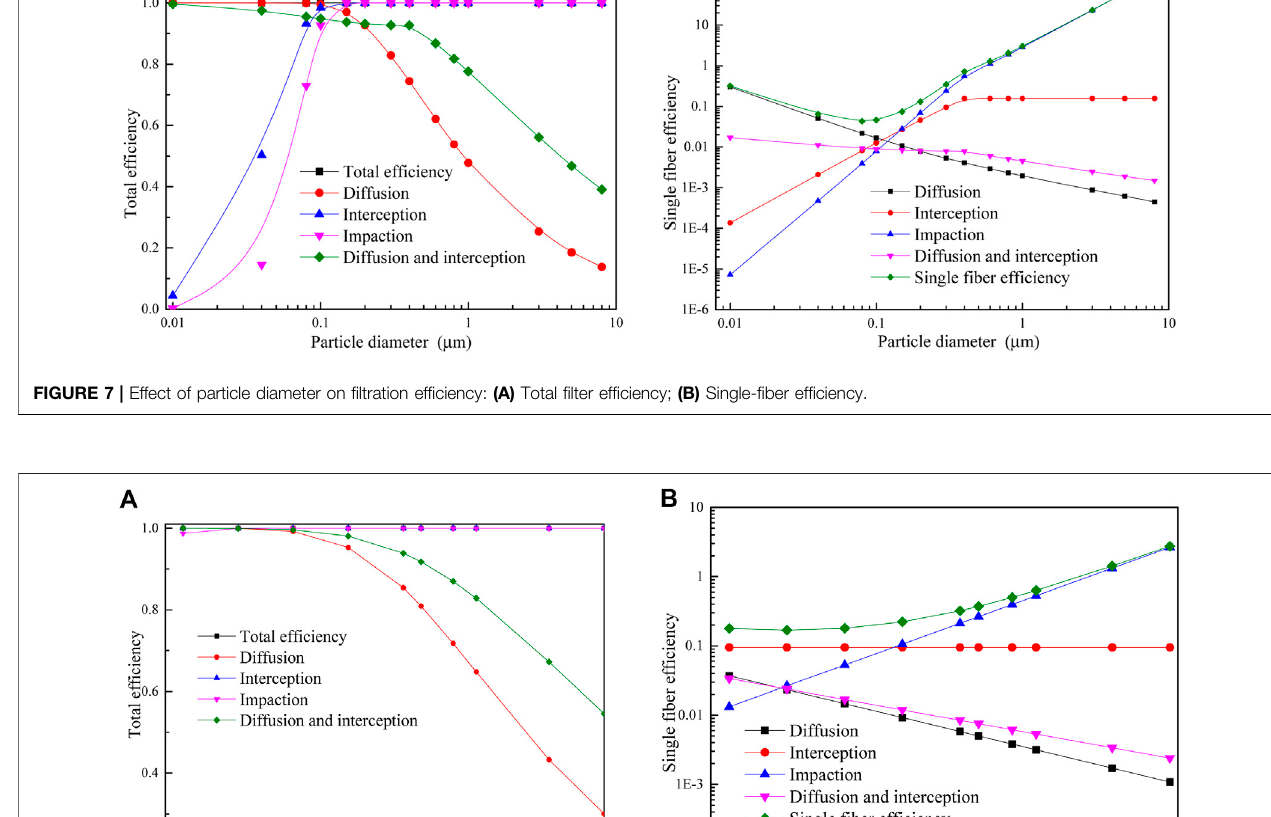
Figure 8 . The fi ltration velocity has an obvious effect on the total